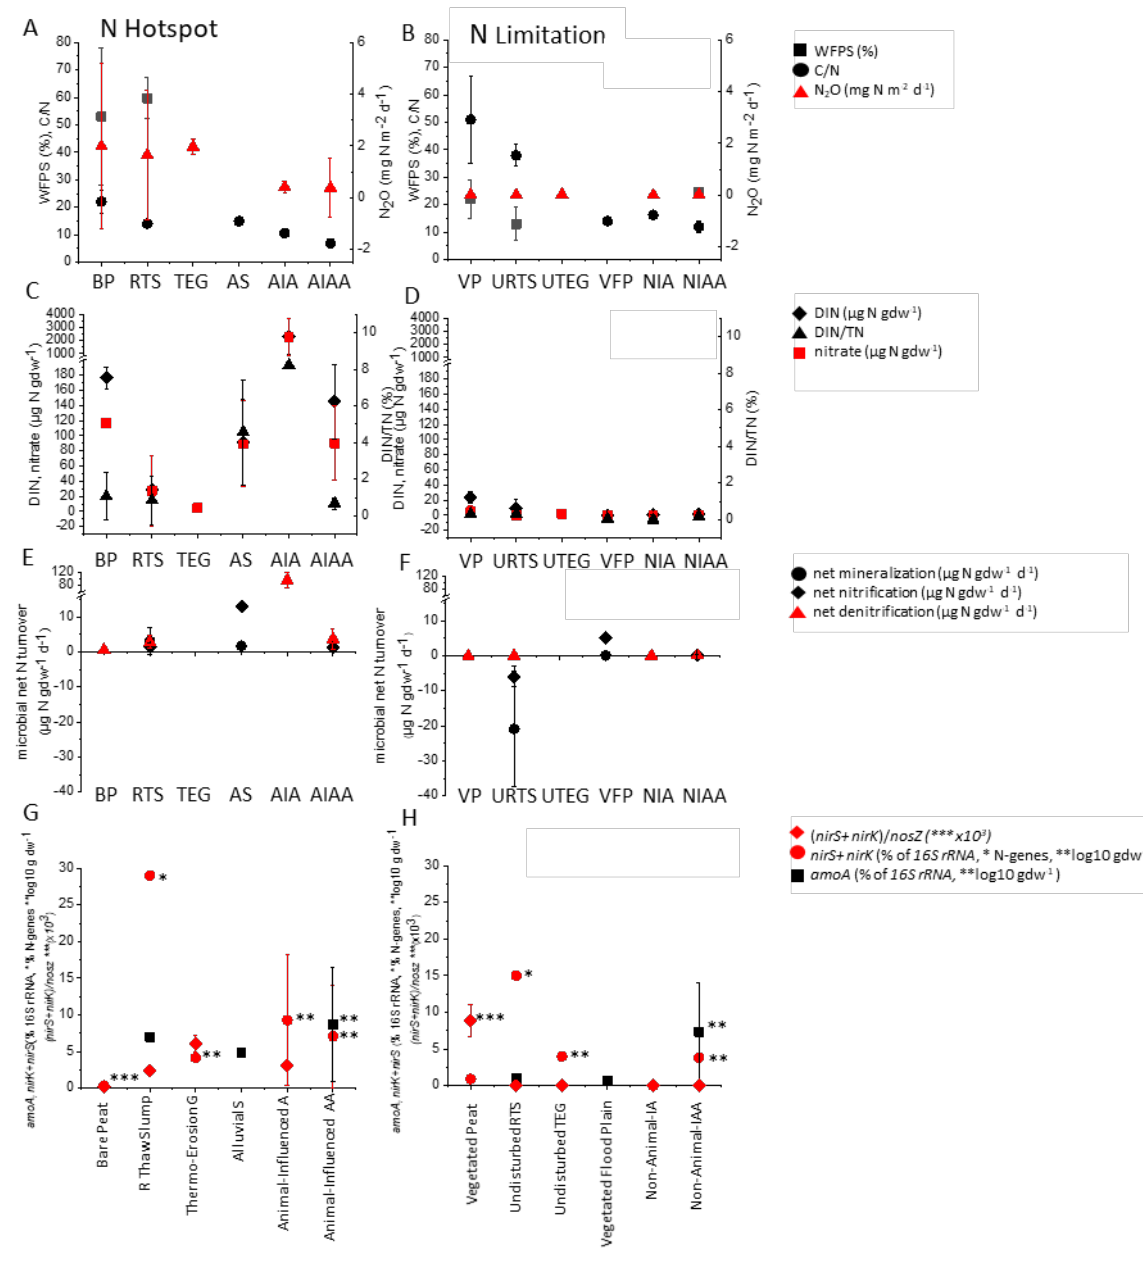
Figure 5. Biochemical traits of ( A , C , E , G ) N hotspots with high N availability and ( B , D , F , H ) adjacent control sites with N limitation using one described site as an example. ( A , B ) water-filled pore space (WFPS), C/N ratio ( C , D ) dissolved inorganic nitrogen (DIN, ammonium + nitrate), ratio of DIN to total N (DIN/TN) and nitrate. ( E , F ) microbial net N turnover: N mineralization, nitrification, denitrification, and ( G , H ) abundance of genes of key functional enzymes of nitrification ( amo , ammonia monooxygenase in % of 16S rRNA and **log10 gdw −1 ), denitrification ( nirS + nir K , nitrite reductases in % of 16S rRNA, *% of N genes and **log10 gdw −1 ) and ( nirS + nirK )/ nosz ratio (nitrite reductase/N 2 O reductase *** × 10 3 ) in subarctic bare (BP) and vegetated peatland (VP, references see Table 1), Arctic retrogressive thaw slump (RTS) and undisturbed site (URTS, references see Table S1), thermoerosion-gully (TEG) and undisturbed site (UTEG) on the Tibet Plateau [218], Arctic bare alluvial soils (AS) and vegetated floodplain (VP) [119,302,304] and animal-influenced permafrost affected soils of the Arctic (AIA) [234] and Antarctic (AIAA) [188,189,236] and non-influenced soils of Arctic (NIA) and Antarctic (NIAA). For more detail, see Table S2.